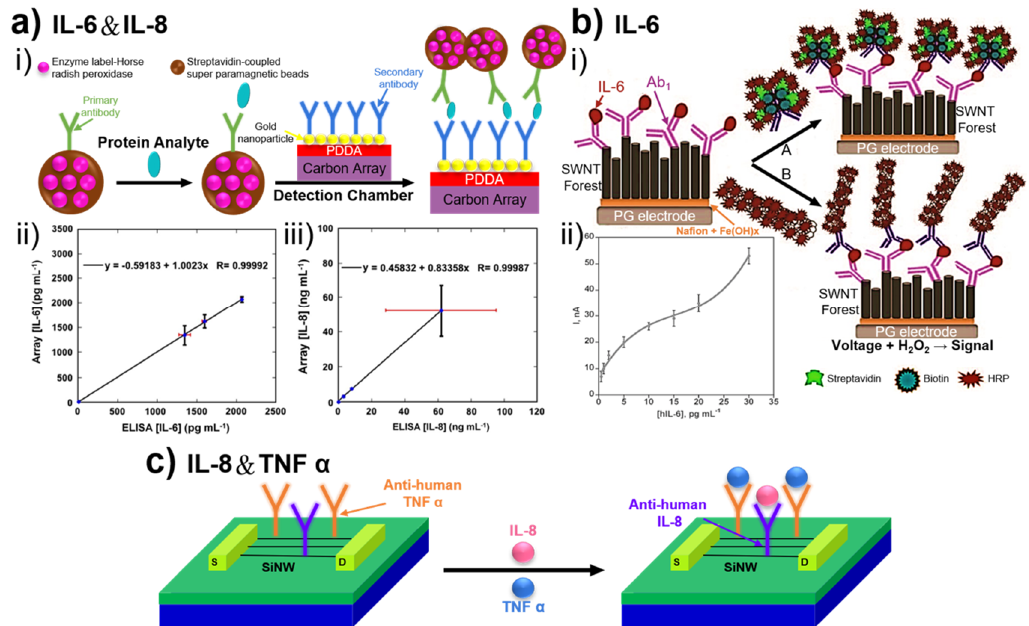
Figure 4. Electrochemical immunosensors based on the detection of biomarkers IL-6 and IL-8 for targeting oral cancer. ( a ) (i) Conceptual strategy for detection of protein biomarker by micro-fluidic immunoarray. Correlation plots of immunoarray assay results for conditioned media of different cell lines vs. standard ELISA assays for: (ii) IL-6; and (iii) IL-8. ( b ) (i) Multilabel amperometric immunosensor; and (ii) influence of IL-6 concentration on steady-state current for immunosensor using the bioconjugate. ( c ) Schematic diagram illustrating SiNW arrays functionalized with two antibodies and two biomarkers. ( a ) Adapted with permission from ref. [31]. Copyright 2014 Elsevier. ( b ) Adapted with permission from ref. [25] Copyright 2010 American Chemical Society.